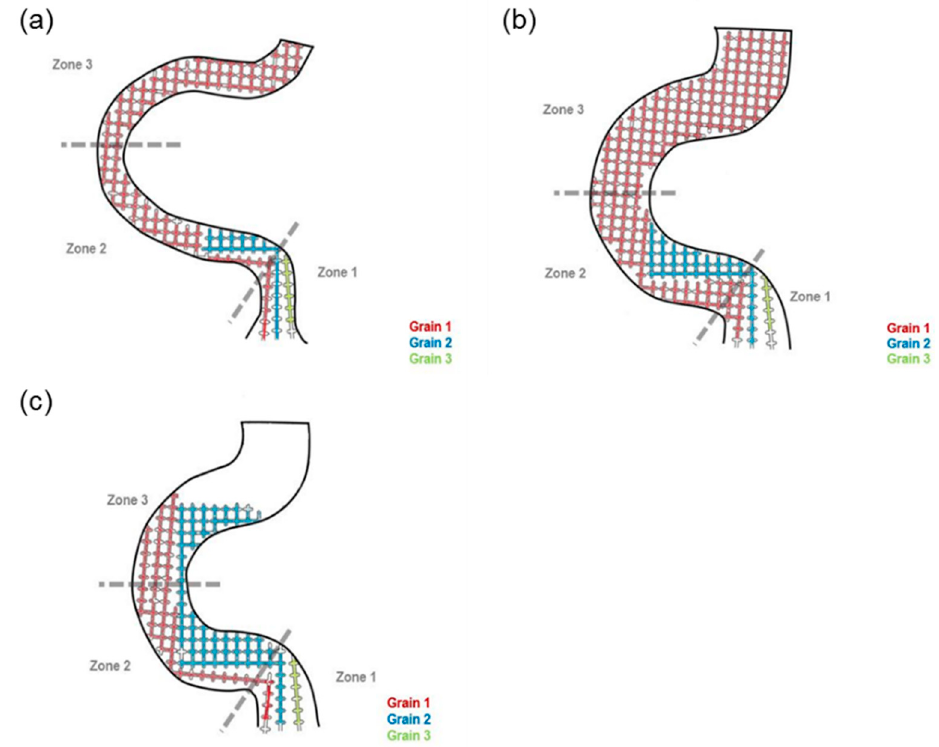
Figure 4. Grains (1, 2, and 3) growth and the selecting mechanism of the selector varying in diameter: ( a ) 2.6 mm, ( b ) 3 mm, and ( c ) 6 mm.